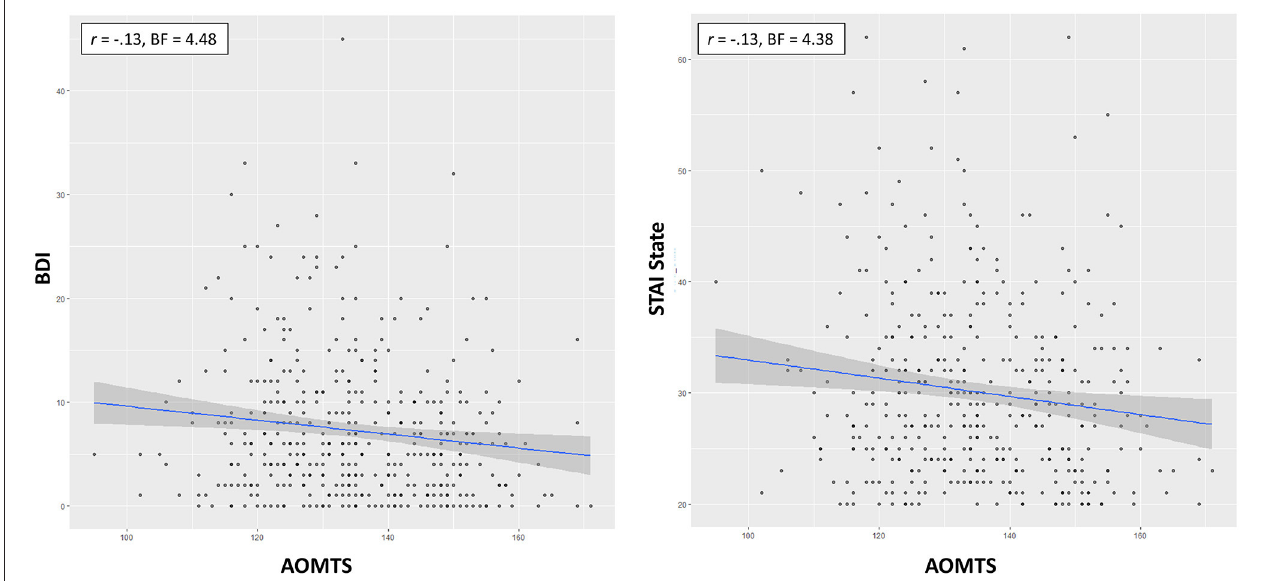
FIGURE 3 | Relationships between self-reported reflectiveness (AOMTS) and depression (BDI) and state anxiety (STAI). Greater reflectiveness was associated with lower symptom levels.